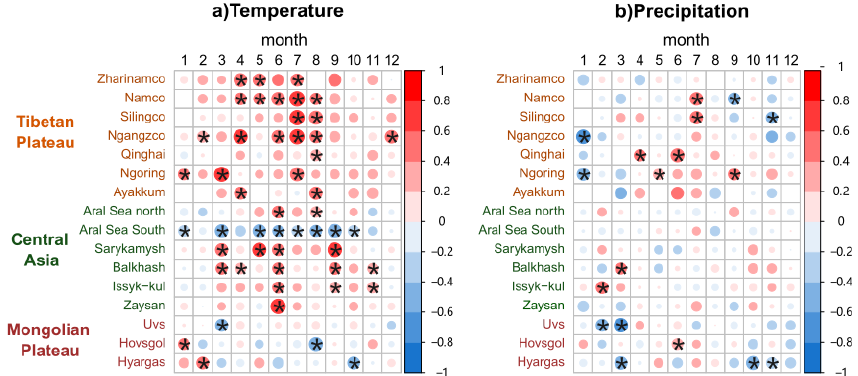
Figure 4. The correlation relationship map between water level variation and monthly precipitation and air temperature over three lakes in the Mongolian Plateau: Asterisks mark significant correlations. The circle size scales with the absolute correlation coefficient value. Table 3. The summary of trends of lake level anomaly, precipitation anomaly and temperature anomaly in the lake over CA, TP, and TP.